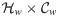
The effect of seasonal and diurnal oscillations on ITQ.GPP dynamics at three flux tower measurement sites from half-hourly to monthly resolution as quantified by a) Hw×Cw, and b) Hw×Fw.